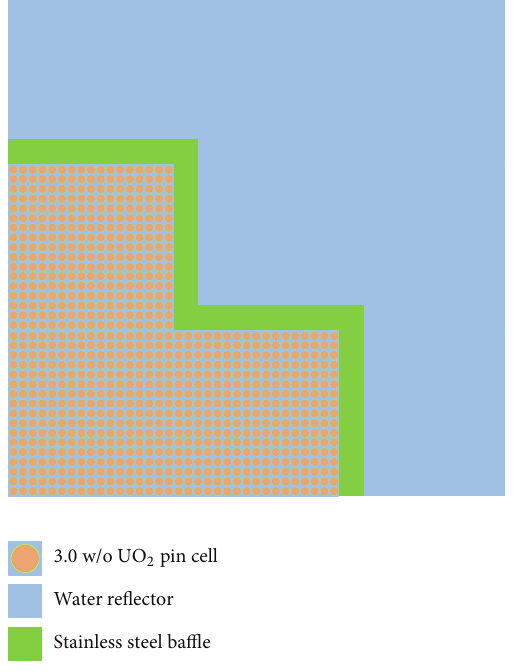
Figure 2: Plan view of 1/4 DIMPLE